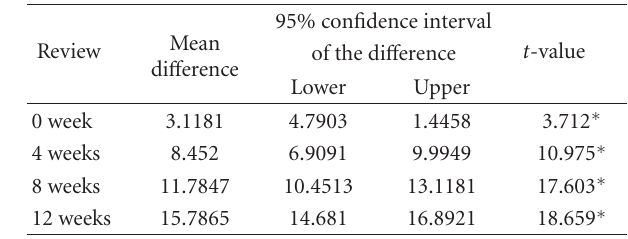
Table 2: Comparison of WOMAC sti ff ness mean score between group A and group B.